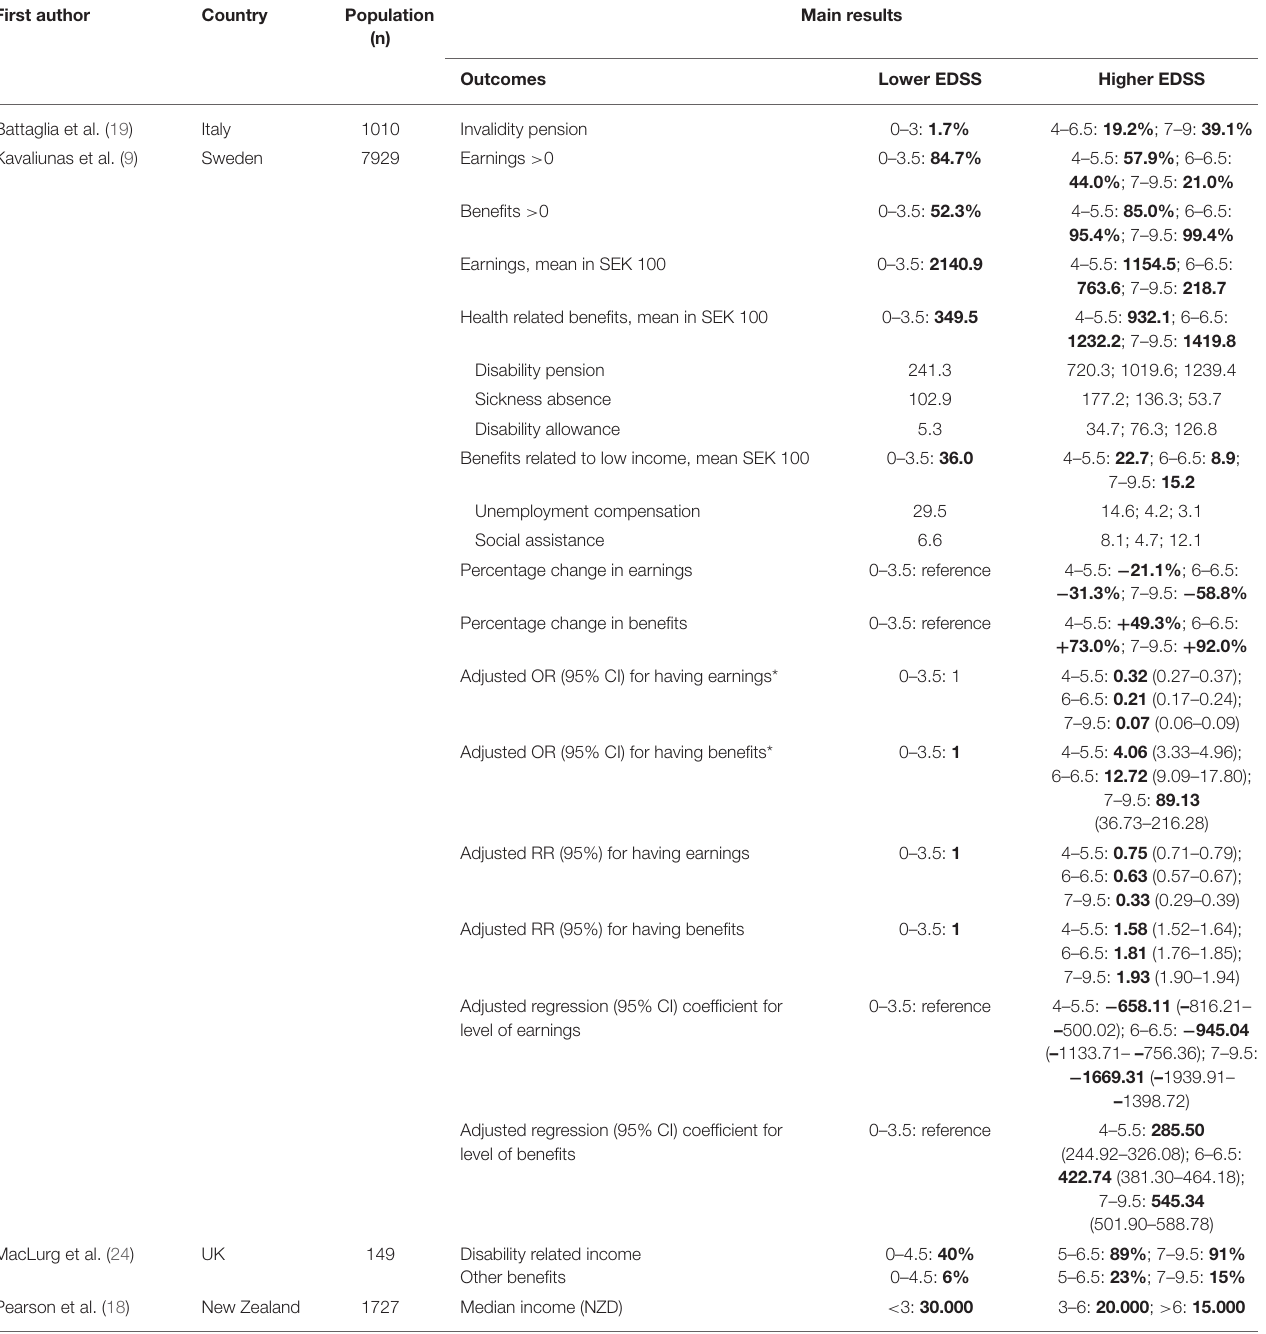
TABLE 4 | Studies that investigated income-related outcomes in patients with MS within different levels of physical